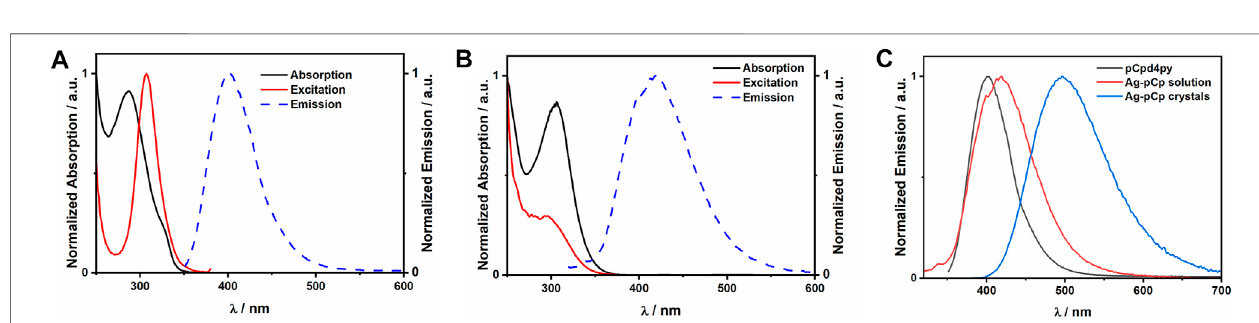
FIGURE3| Plotsofthenormalized absorption,excitationandemissionspectrafor (A) pCpd4py inacetonitrile, (B) Ag-pCpindichloromethane. (C) Comparisonof the emission spectra for the ligand and Ag-pCp in solution and crystalline states.